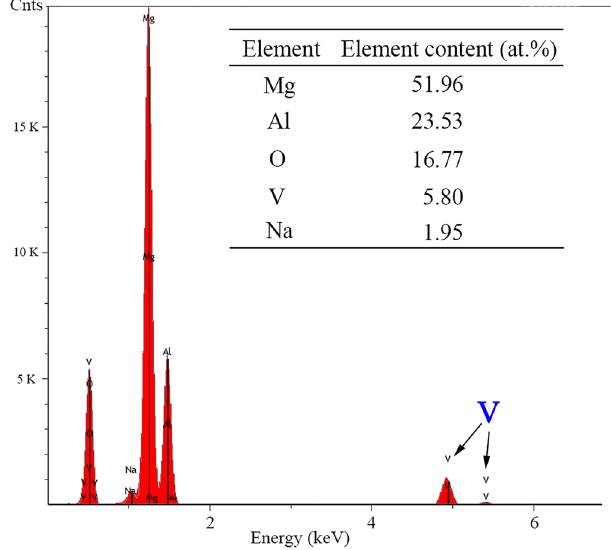
Figure 3. The spectra of point EDS analysis for SMV specimen.